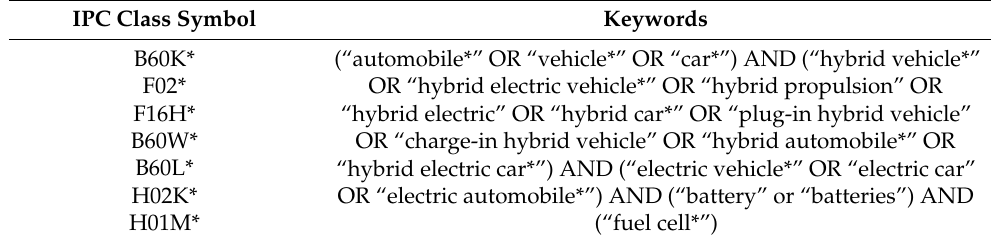
Table 1. Data search strategy to define “green”